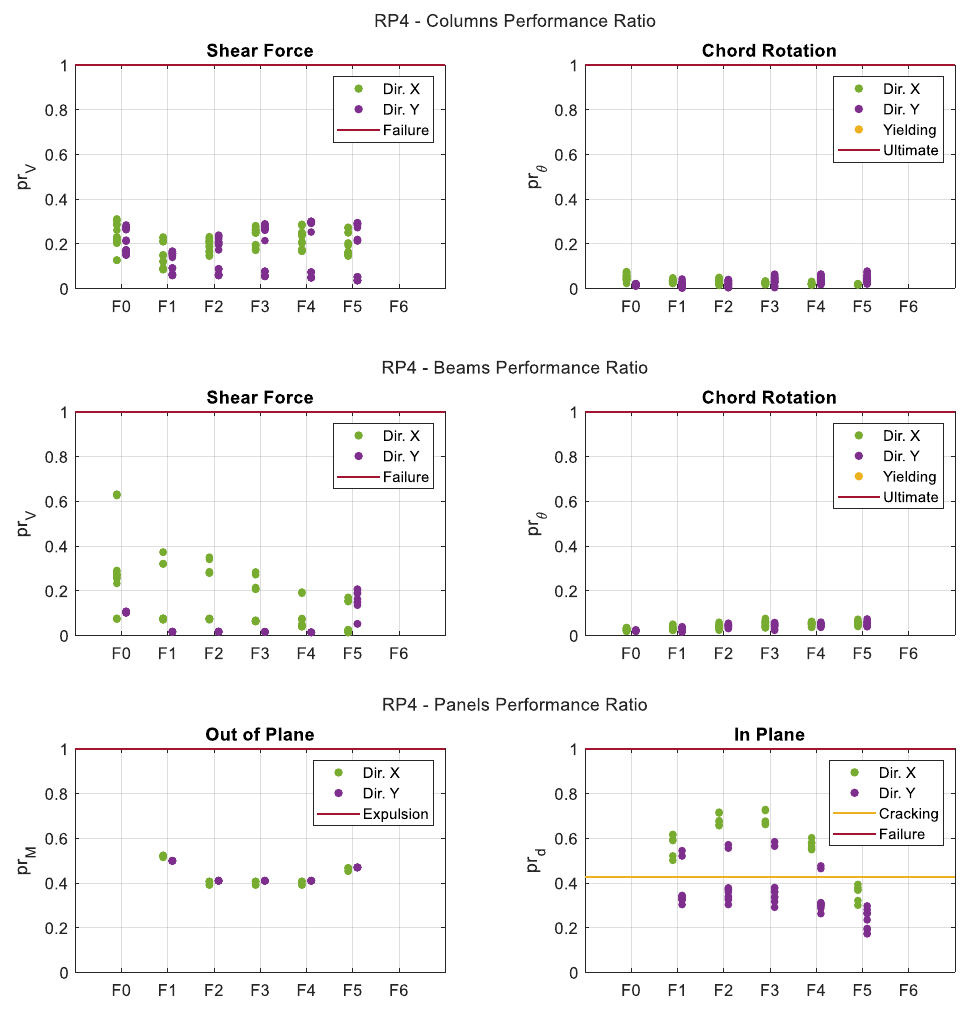
Figure 24. RP4 RC elements and infill panels performance ratios.